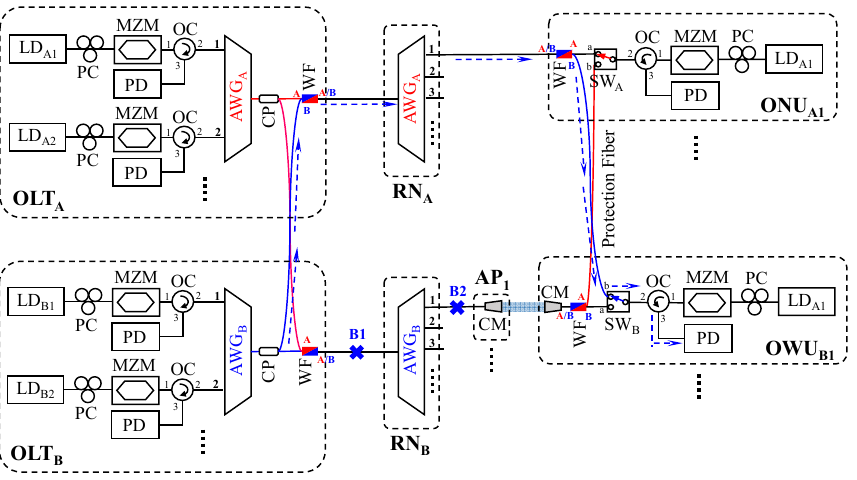
Figure 3. Assume the fiber breakage occurs at the “B1” and “B2” point in the proposed fiber-FSO WDM-PON system, respectively.